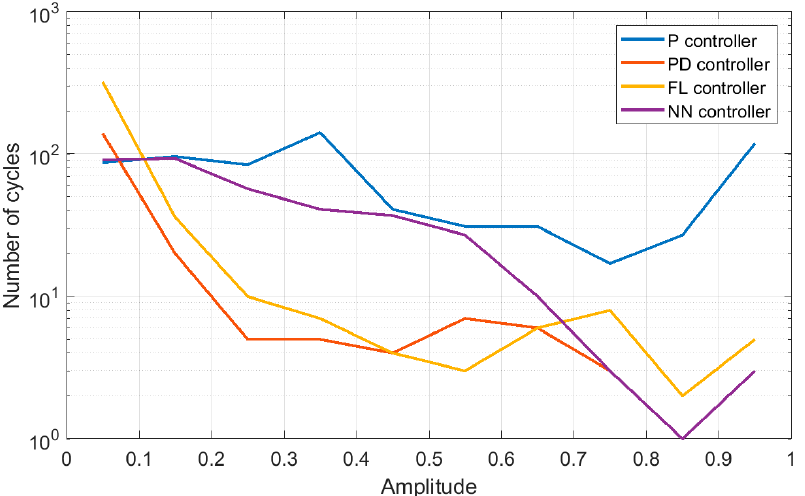
Figure 18. Amplitude-cycles curve. Conditions: setpoint—chirp signal; observation time − 1000 s.